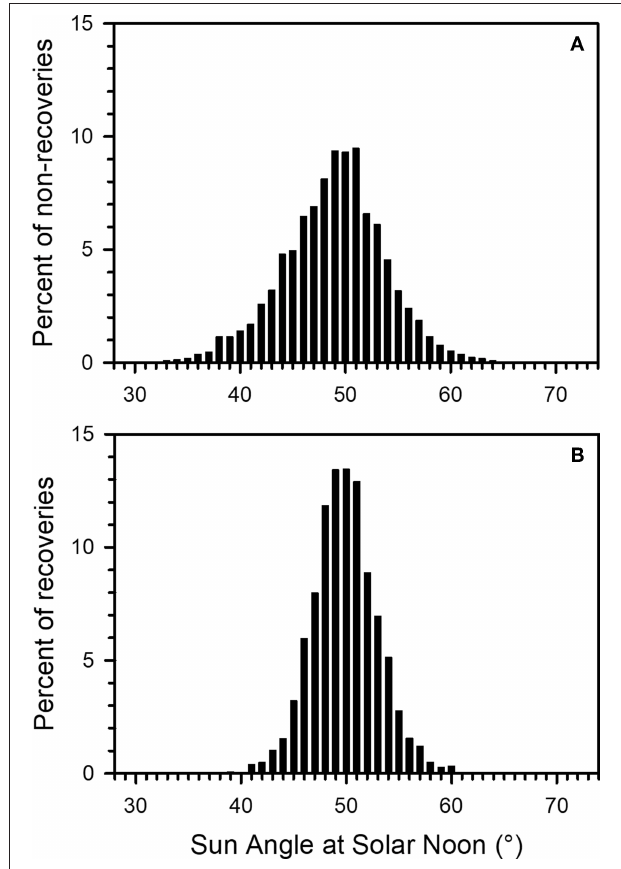
FIGURE 7 | Distribution of Sun Angle at Solar Noon (SASN) at time of tagging for monarch tags (A) not recovered in Mexico and (B) recovered in Mexico, for wild-caught monarchs from 2004 to 2015. Y-axis is percentage of total not-recovered or recovered tags.